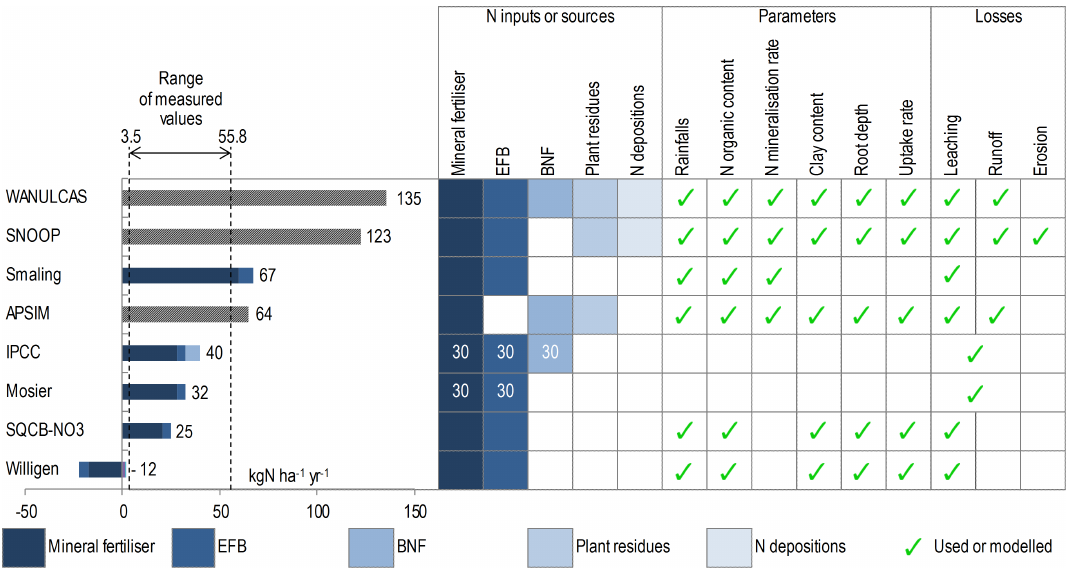
Figure 3. Comparison of annual average losses through leaching and runoff, estimated by eight sub-models. The average loss estimate was 59kg Nha − 1 yr − 1 . The results represented mostly losses through leaching due to low values for runoff losses (<0.06kg Nha − 1 yr − 1 ) . The hatched bars represent calculations which include several sources at once: in WANULCAS, SNOOP, and APSIM, all sources are considered in the same calculation. Measured values are from Pardon et al. (2016). The table shows the N inputs and parameters used by the sub-models, and emission factors for linear relationships. Emission factors are in %; e.g. in IPCC-2006, leaching and runoff are 30% of mineral N